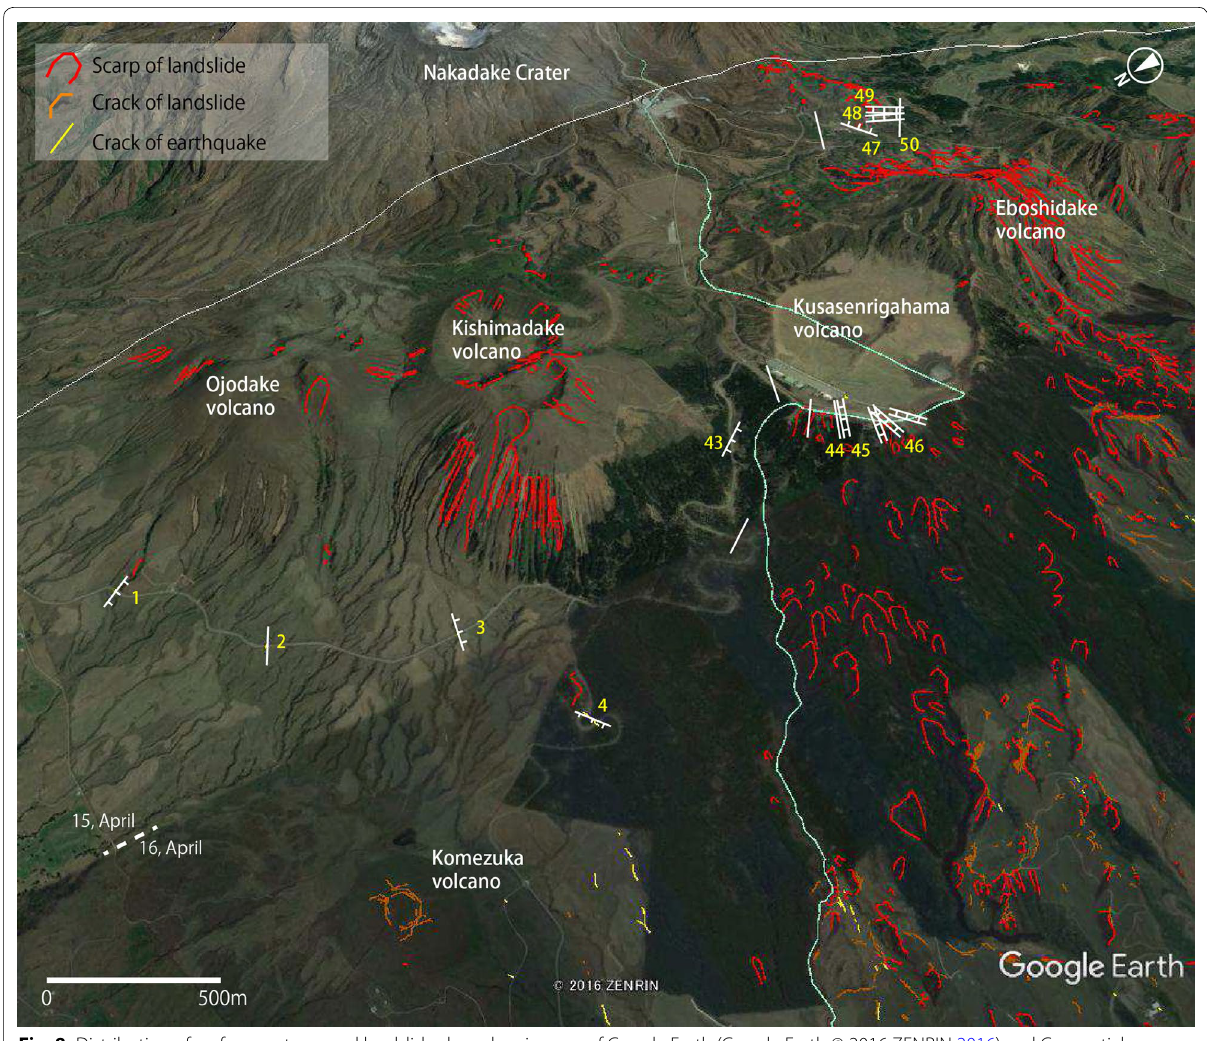
Fig. 8 Distribution of surface ruptures and landslides based on images of Google Earth (Google Earth © 2016 ZENRIN 2016) and Geospatial Information Authority of Japan (2016). The landslides are concentrated from north Kusasenrigahama to south Ebosidake in this aerial view. The two bands of concentrated landslides occur around the concentrated surface ruptures at the north Kusasenrigahama and east Eboshidake volcano